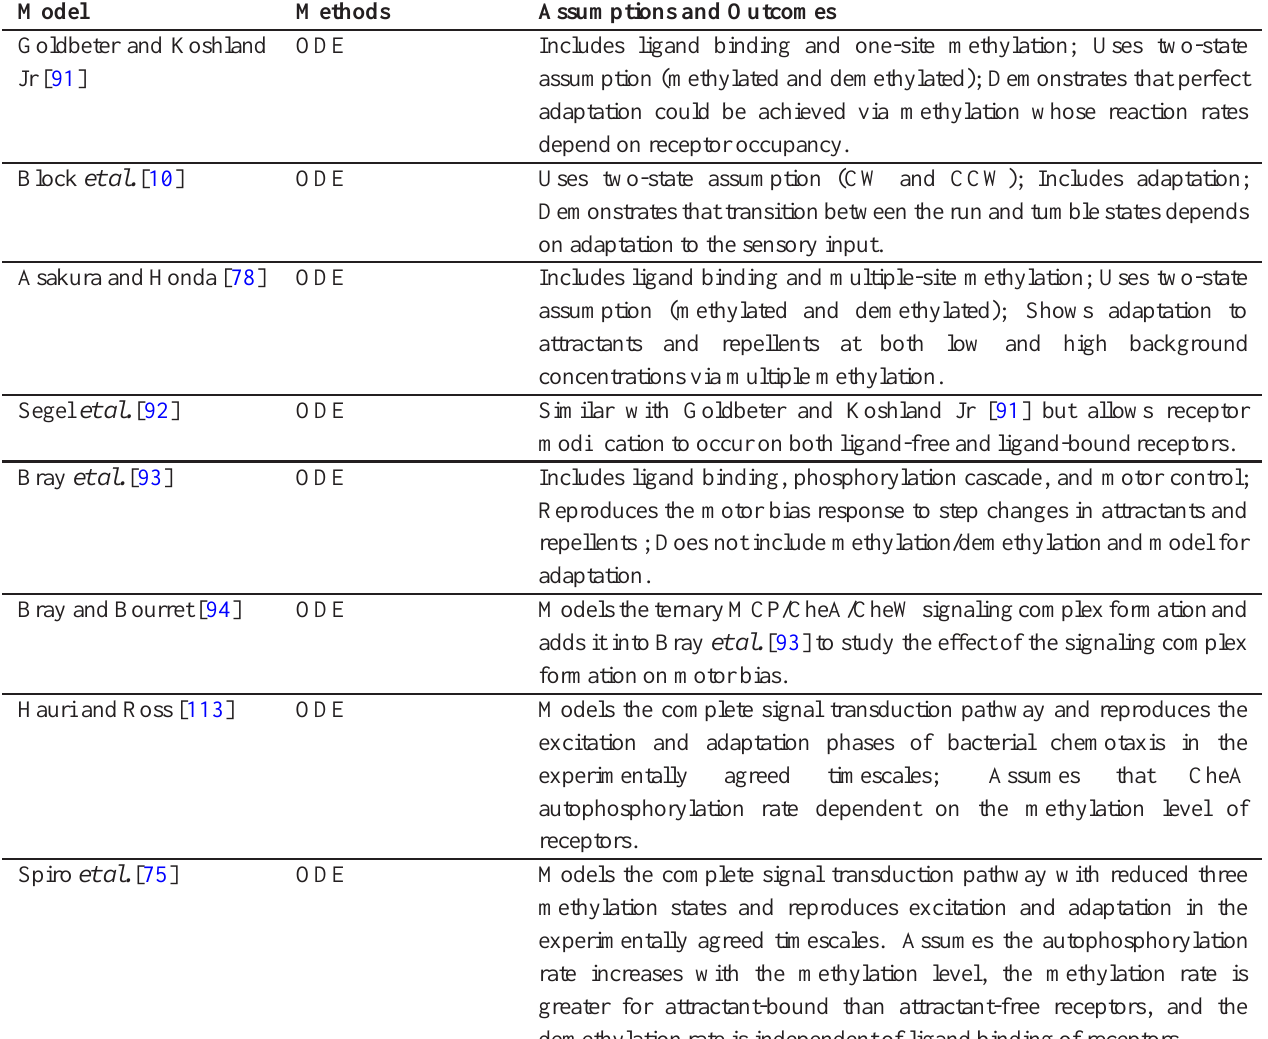
Table 2. Mathematical models of bacterial chemotaxis